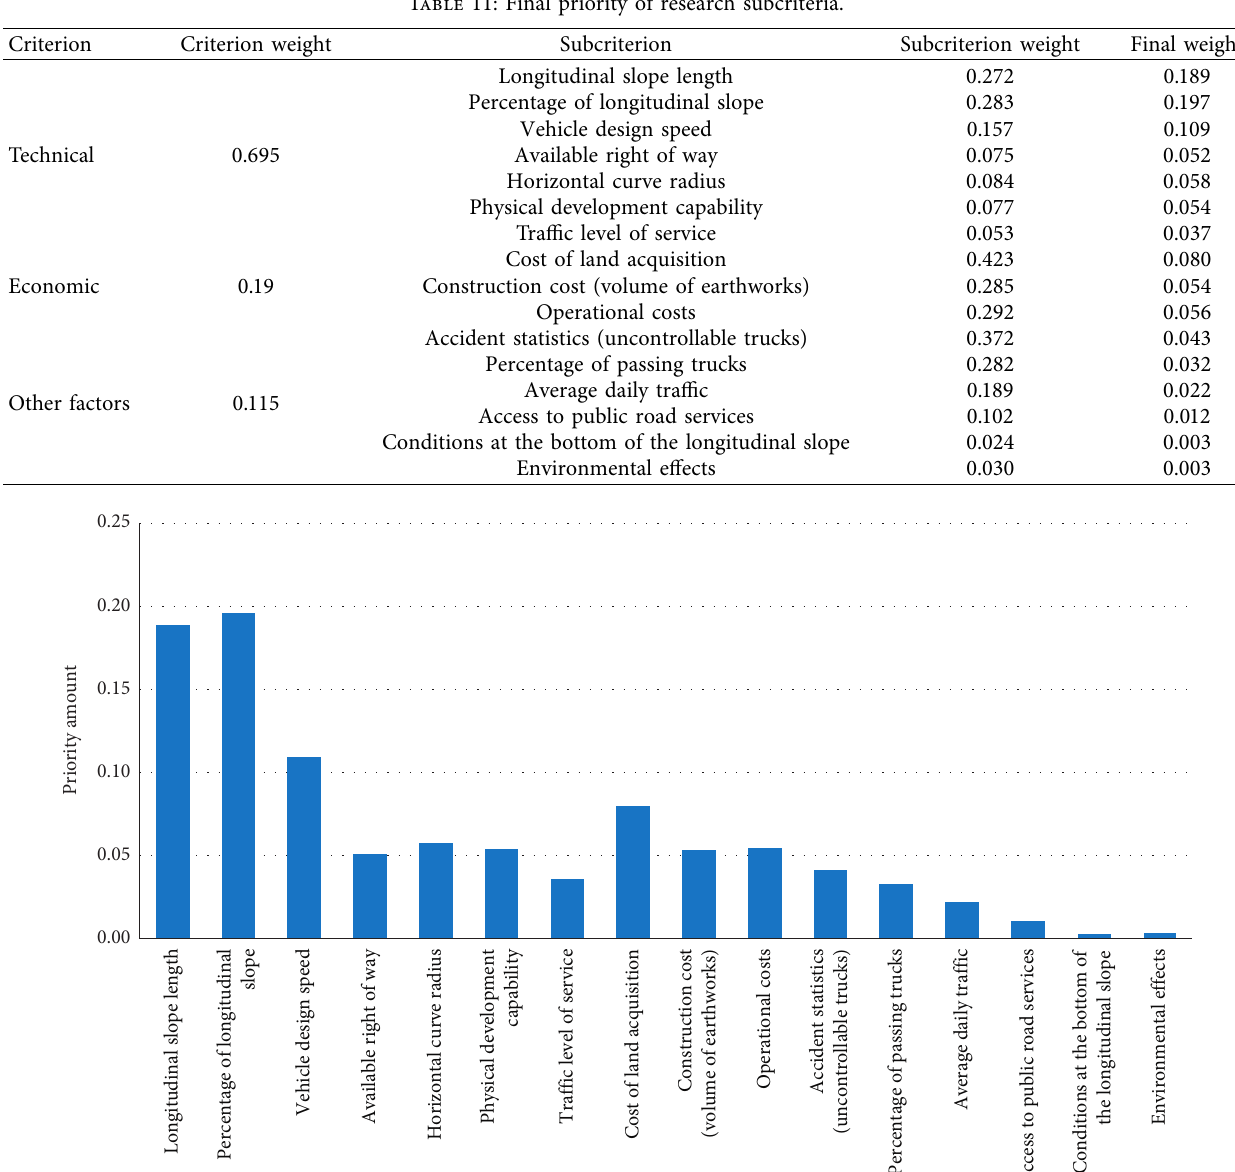
Figure 9: Final priority of research